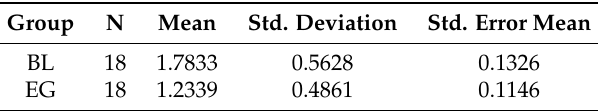
Table 2. Knowledge intake group statistics.